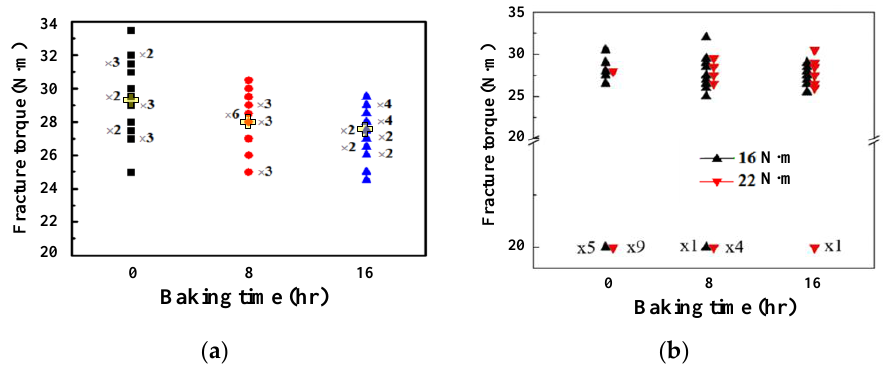
Figure 4. ( a ) Twist ‐ off strength (cross symbol: average fracture torque; ×2: 2 screws; ×3: 3 screws, the rest by analogy) and ( b ) HE testing results of 10B21 screws baked for various durations (×5: 2 screws; ×9: 9 brittle fracture screws, the rest by analogy).